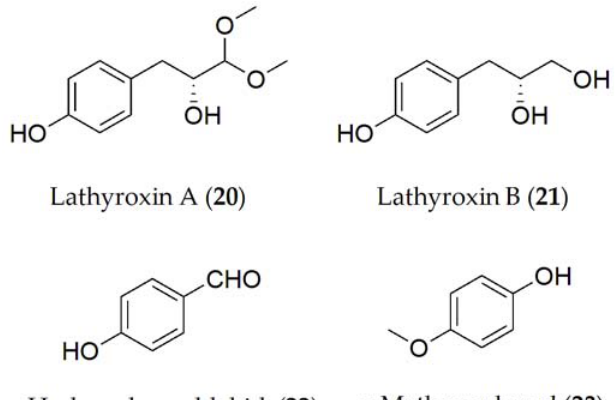
Figure 4. Phytotoxins isolated from Ascochyta pisi var. lathyri .